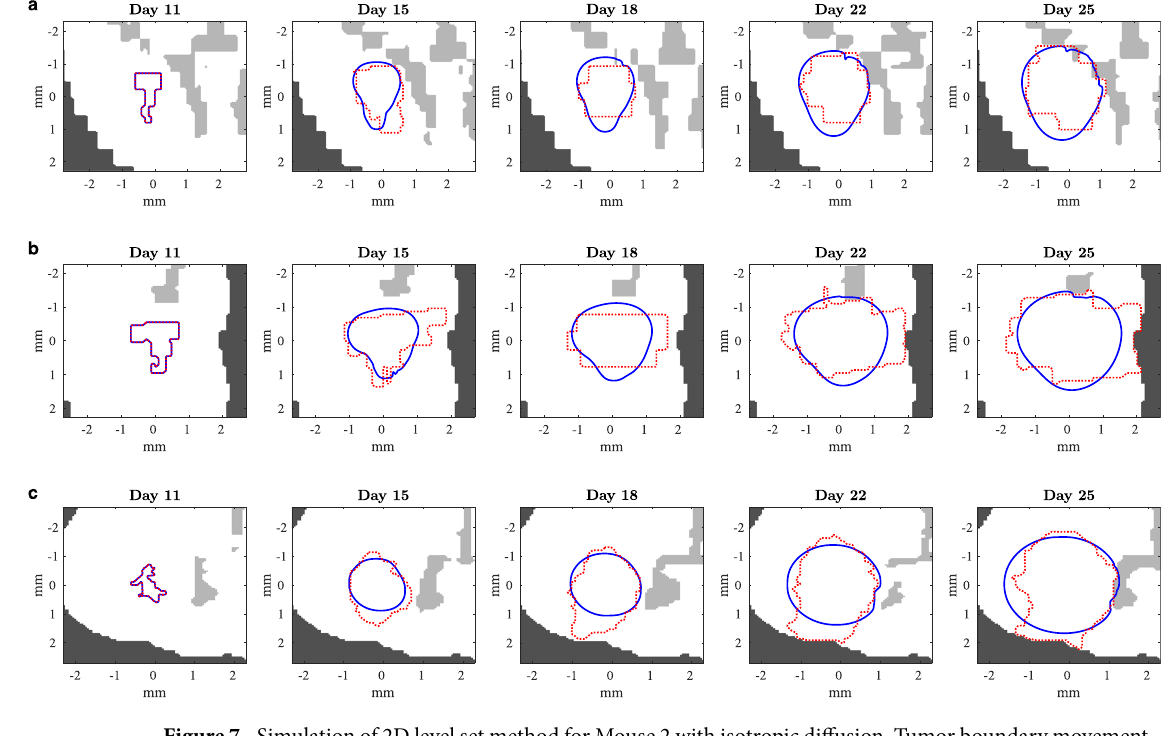
Figure 7. Simulation of 2D level set method for Mouse 2 with isotropic diffusion. Tumor boundary movement in Mouse 2 in select slices with estimated parameters from Table 4. The red dotted curve represents the tumor boundary from the laboratory imaging and the solid blue curve, the boundary from the 2D mathematical model. The light gray regions are ventricles and the dark gray regions are outside of the brain. ( a ) Transverse section; ( b ) sagittal section; ( c ) coronal section.